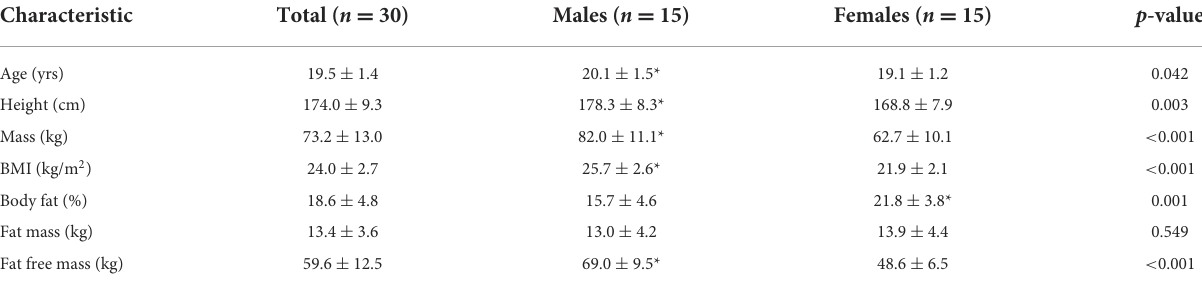
TABLE 2 Physical characteristics (means ± SD) of subjects ( n =